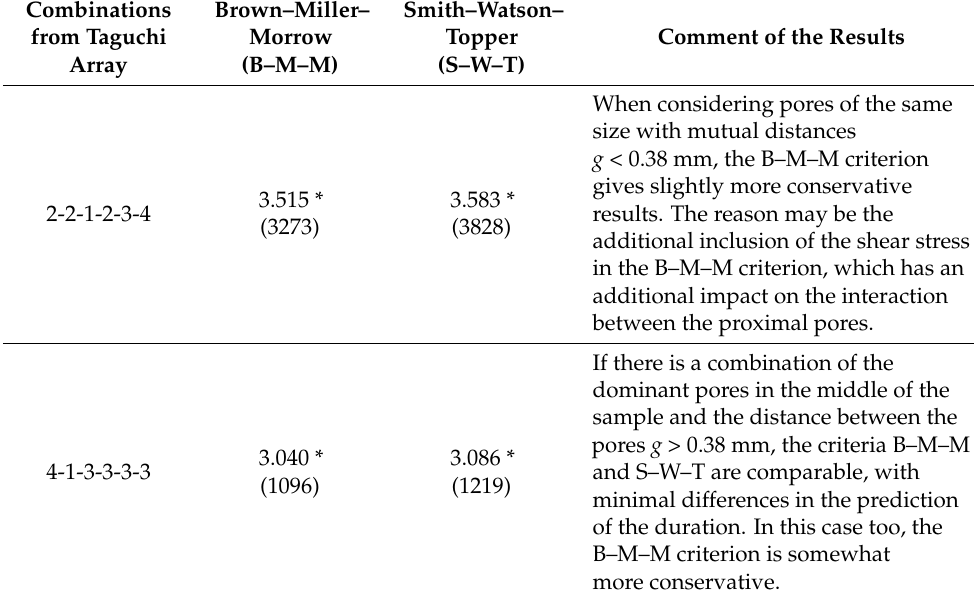
Table 4. A duplicate response for two pore combinations using two different algorithms.